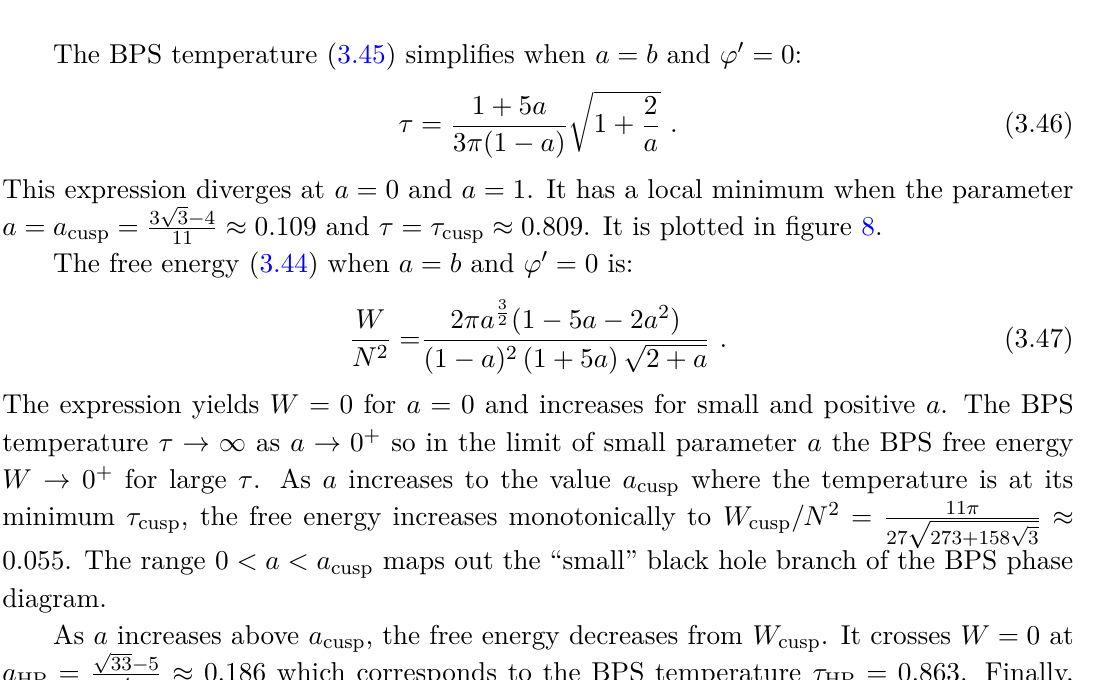
Figure 8 . The BPS temperature τ as function of the rotation parameter a when a = b and ϕ 0 = 0 . The local minimum determines the position of the cusp in the phase diagram. The divergences at a = 0 and a = 1 correspond to the large- τ extremes of the “small” and “large” black hole branches,